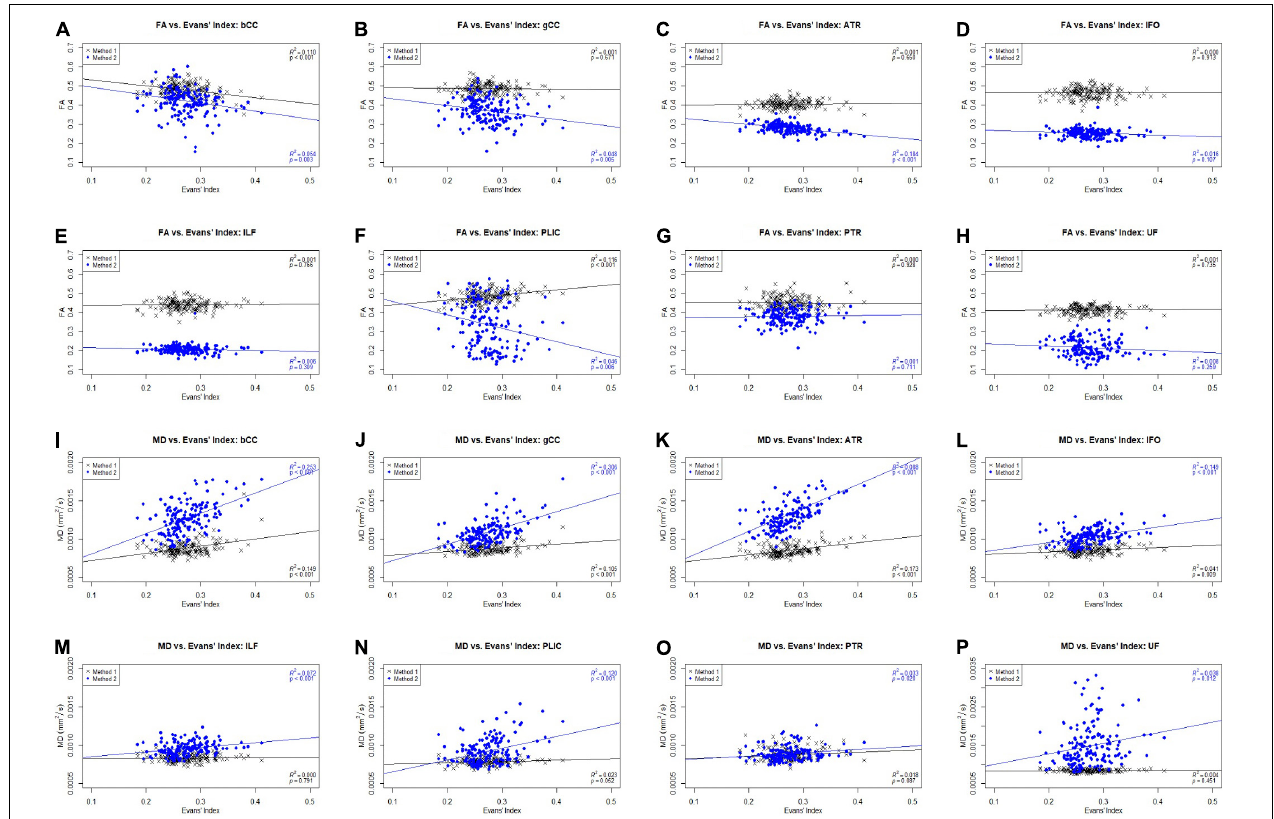
FIGURE 4 | Scatter plots of FA and MD against Evans’ index (EI) across white matter tracts for CN, AD, and EMCI cohorts combined. gCC, genu of the corpus callosum; bCC, body of the corpus callosum; ATR, anterior thalamic radiation; IFO, inferior fronto-occipital fasciculus; ILF, inferior longitudinal fasciculus; PLIC, posterior limb of the internal capsule; PTR, posterior thalamic radiation; UF, uncinate fasciculus. (A) FA vs. Evans’ Index: bCC. (B) FA vs. Evans’ Index: gCC. (C) FA vs. Evans’ Index: ATR. (D) FA vs. Evans’ Index: IFO. (E) FA vs. Evans’ Index: ILF. (F) FA vs. Evans’ Index: PLIC. (G) FA vs. Evans’ Index: PTR. (H) FA vs. Evans’ Index: UF. (I) MD vs. Evans’ Index: bCC. (J) MD vs. Evans’ Index: gCC. (K) MD vs. Evans’ Index: ATR. (L) MD vs. Evans’ Index: IFO. (M) MD vs. Evans’ Index: ILF. (N) MD vs. Evans’ Index: PLIC. (O) MD vs. Evans’ Index: PTR. (P) MD vs. Evans’ Index: